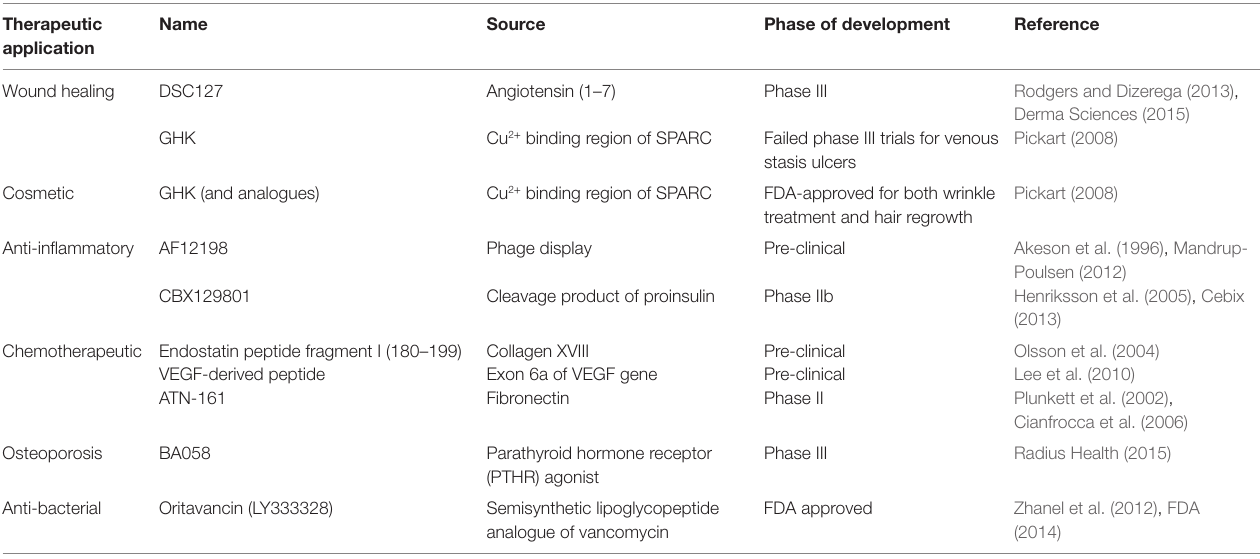
TABLe 1 | examples of therapeutic